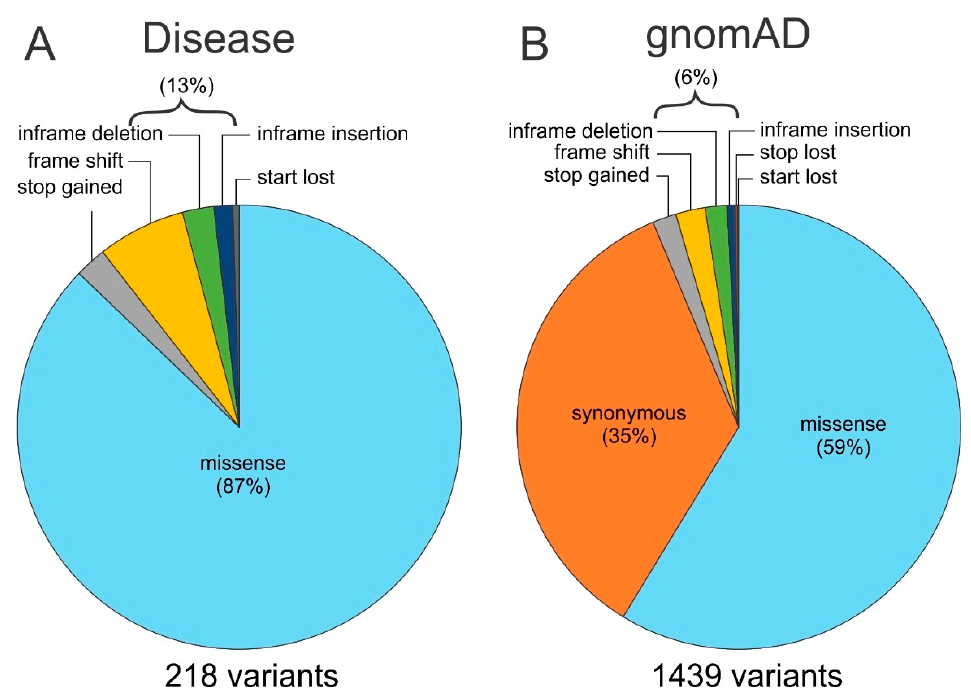
Figure 2. Pie charts to show proportions of different types of variants. The total number, type, and their relative percentage (calculated by the number of unique variants for each variant type) in four α -connexins (Cx43, Cx46, Cx40, and Cx50) are shown as pie charts. ( A ) The pie chart illustrates the disease-linked variants. ( B ) The pie chart shows the variants identified in the reference genome database, gnomAD (V2.1.1). Synonymous variants were not reported from the disease-linked variants, and in both cases, the number of unique missense variants showed the highest percentage.